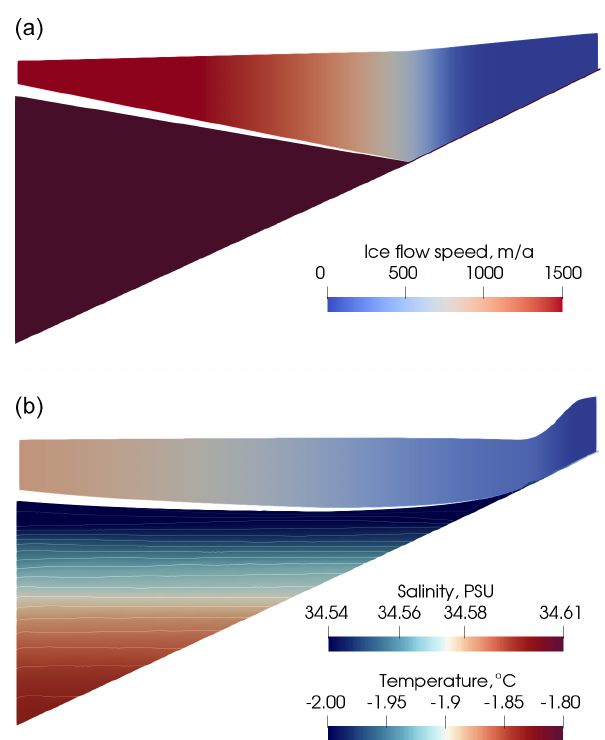
Figure 6. Profiles through the centre line for experiment VE2 af- ter the first ice component time step (a) and after 25 years (b) . Ice flow speed is shown (flow direction is right to left). Ocean temper- ature (solid colour) and salinity (contours) are shown after 25 years (these are uniform at the start of the run, hence the solid colour for the ocean in the upper plot). Vertical exaggeration is 50 times. The gap between ocean and ice shelf is half an ocean grid cell and is a plotting artefact (the upper extent of the plotted region for the ocean is the uppermost rho point, which is half an ocean grid cell below the top of the ocean